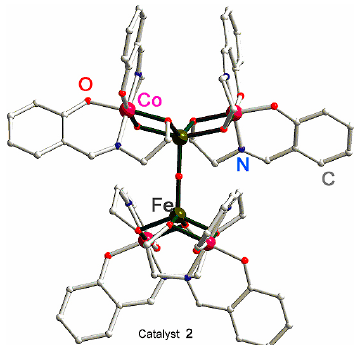
Figure 2. Molecular structure of [Co III4 Fe III2 O(L 4 ) 8 ] ∙ 4DMF ∙ H 2 O (complex 2 ). Solvated DMF and water molecules have been omitted for clarity. Adapted from Ref. [160].